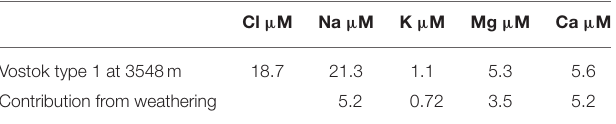
TABLE 2 | Cation and Cl − concentrations measured in Vostok accretion ice sample 3548